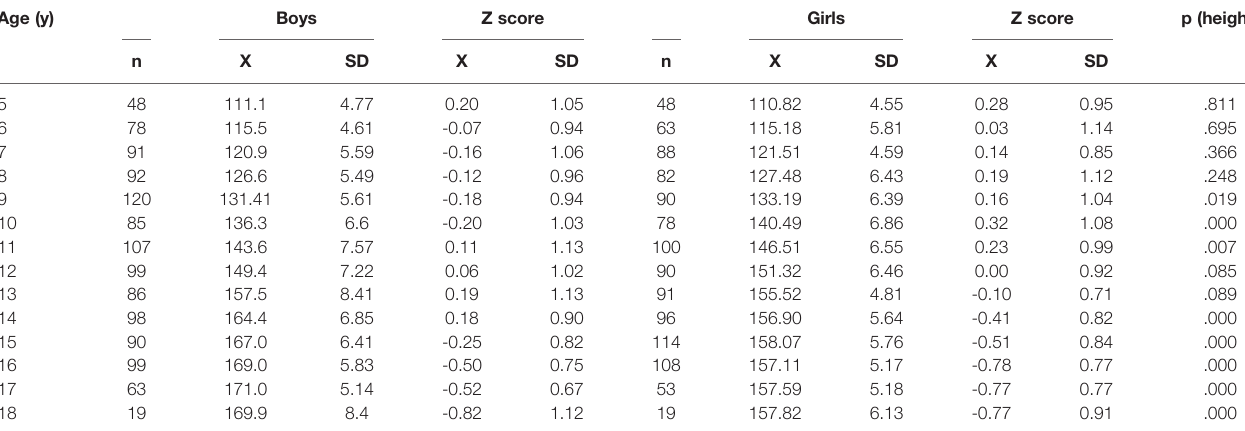
TABLE 1 | Descriptive values (mean ± SD) and Z-score of the height of children and adolescents in Colombia. Age (y) Boys